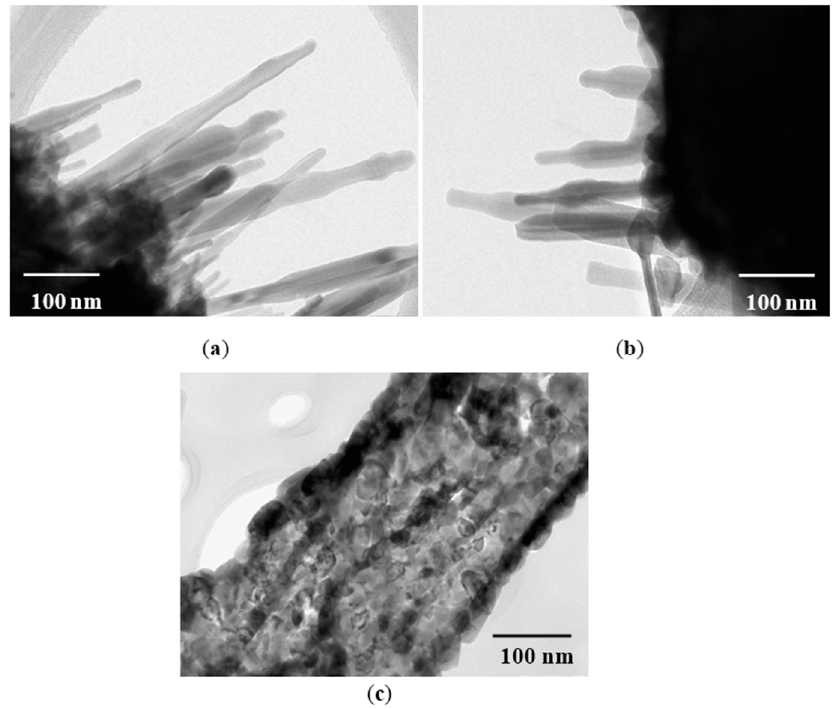
Figure 4. TEM images of MgSb 2 O 6 powders calcined at 800 °C: ( a , b ) nanorods; ( c ) surface of a rod with nanoparticles.